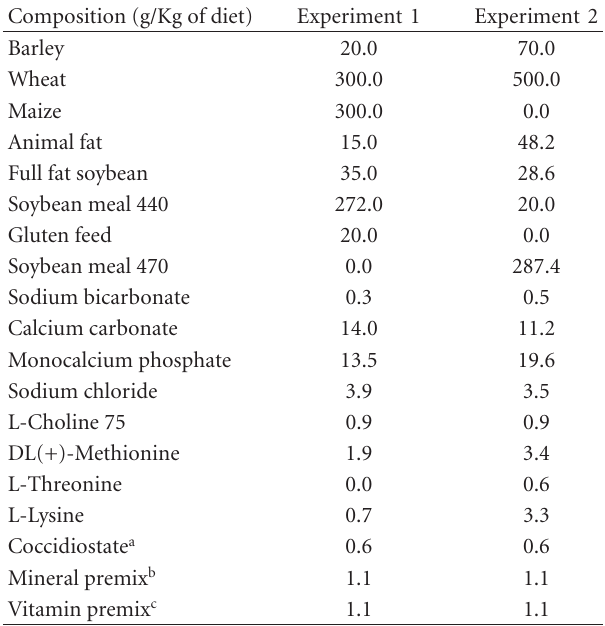
Table 2: Composition of the basal diets of both experiments. Composition (g/Kg of